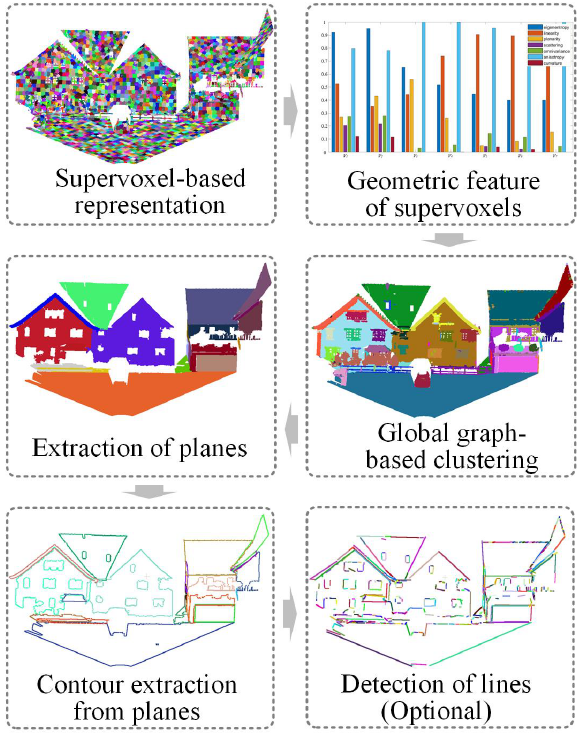
Figure 1. Workflow of the proposed